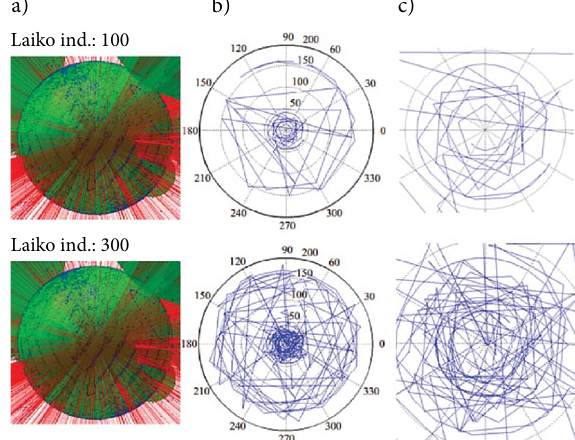
Fig. 7. Angles a particular point. Numbers in brackets are [ g